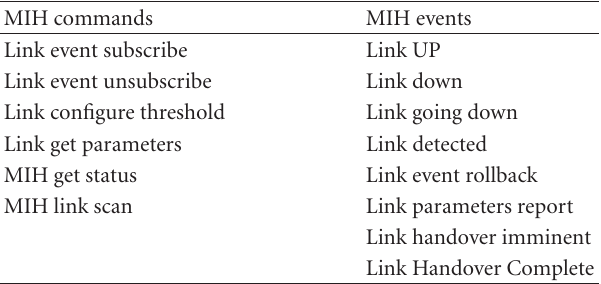
Table 2: Supported MIH commands and events in